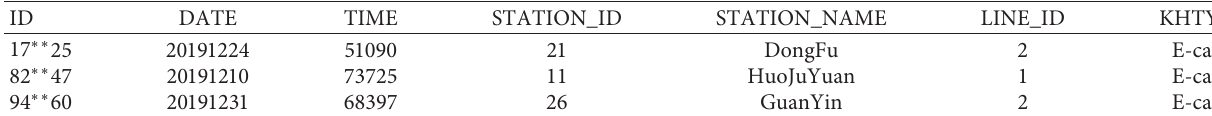
Table 2: The sample of Xiamen